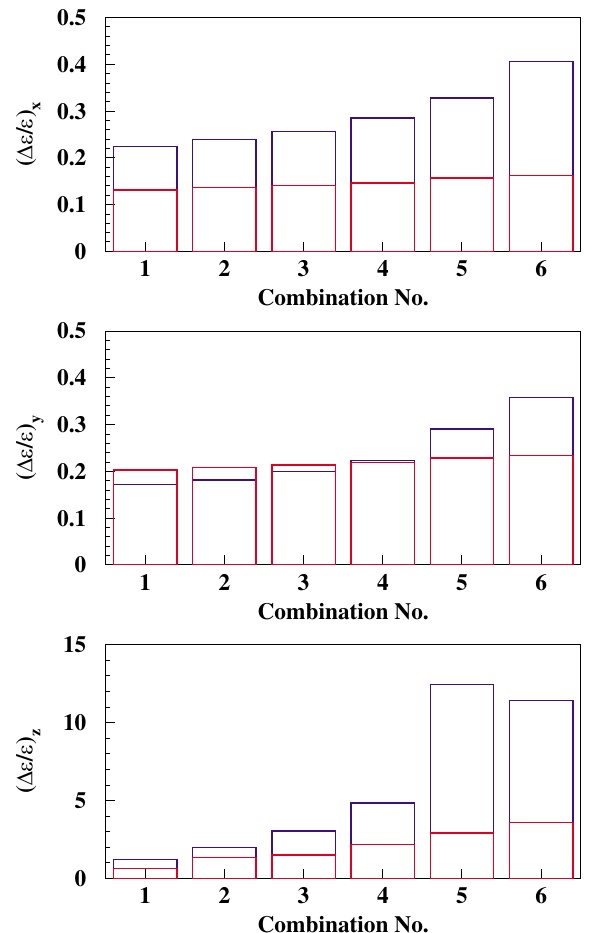
FIG. 14. (Color) Transverse and longitudinal emittance growth for the different error combinations of Table II relative to the case without errors. The blue curves are for the baseline design and the red ones are for the triple-spoke design.